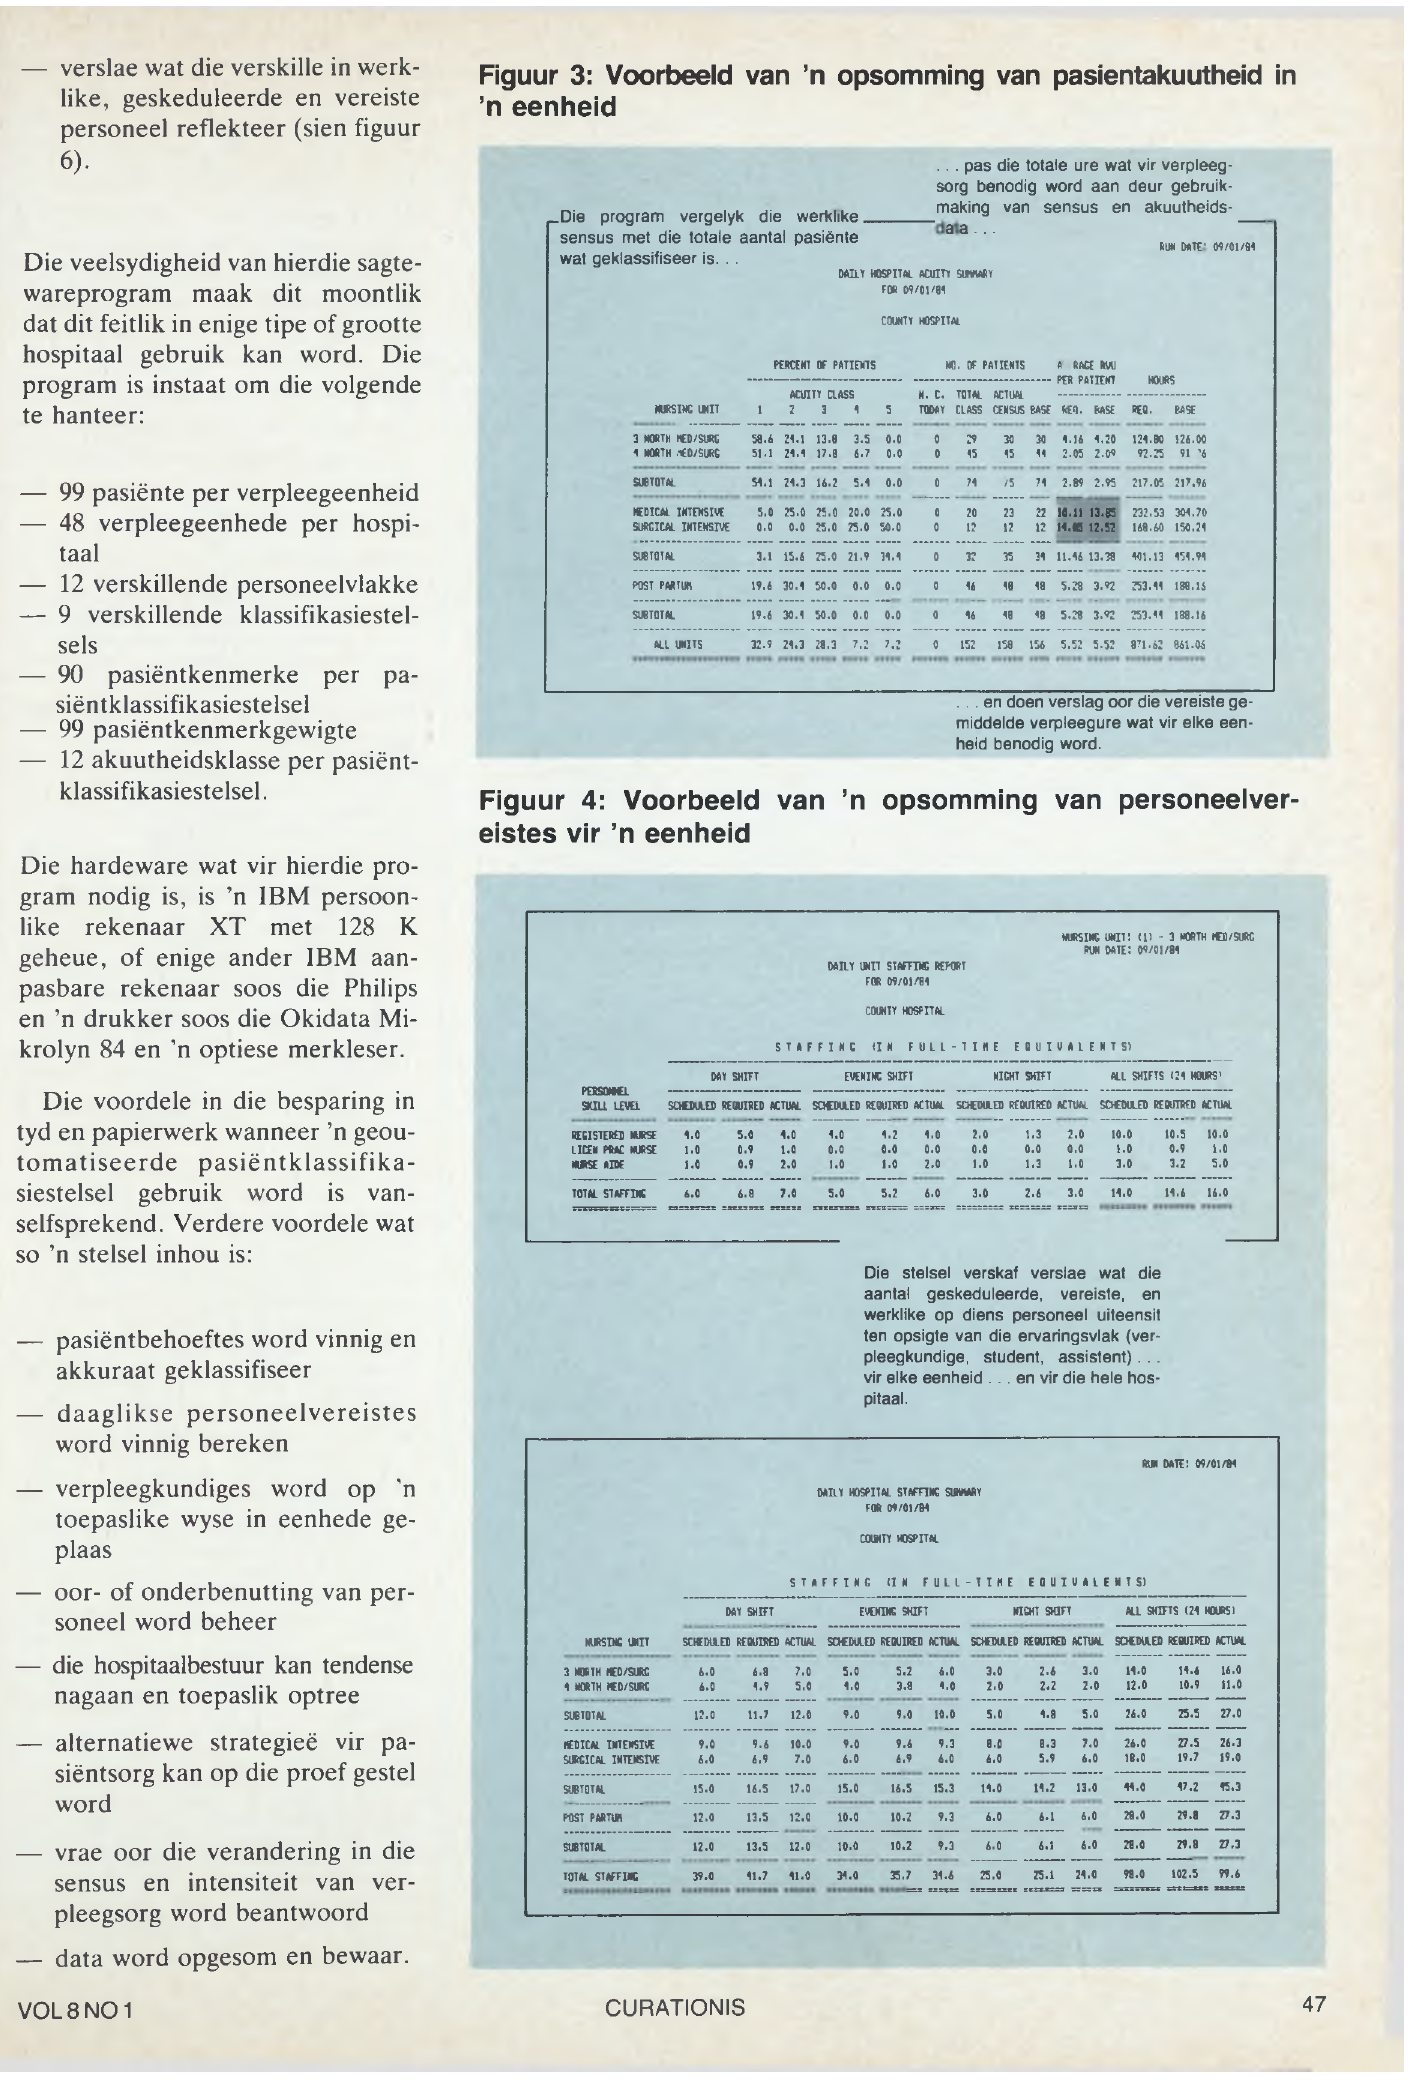
Figuur 4: Voorbeeld van ’n opsomming van